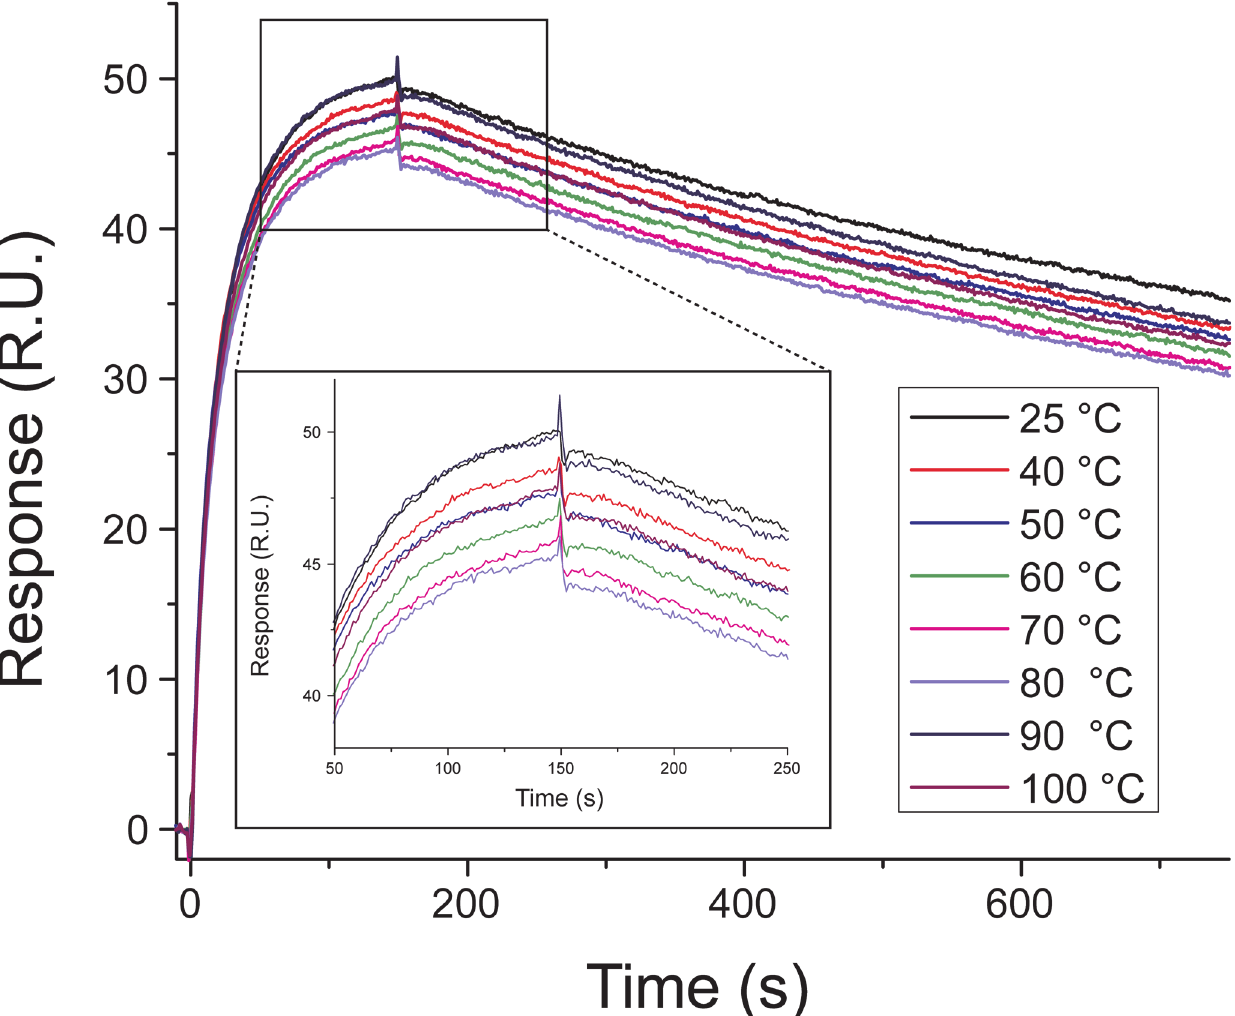
Fig 6. Effect of temperature on GFP-Nb stability. The sensorgrams illustrates the binding of 30 nM GFP to the GFP-Nb immobilized on a Ni:NTA surface. Before immobilization, the nanobody had been heated at the temperatures indicated in the figure for 30 min and then allowed to cool down at room temperature for 30 min. The inset shows a zoom of the sensorgrams recorded between 50 s and 250